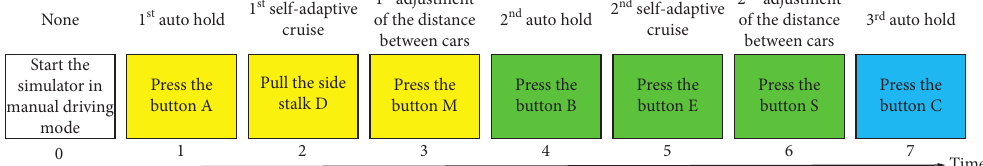
Figure 2: The task flow of the